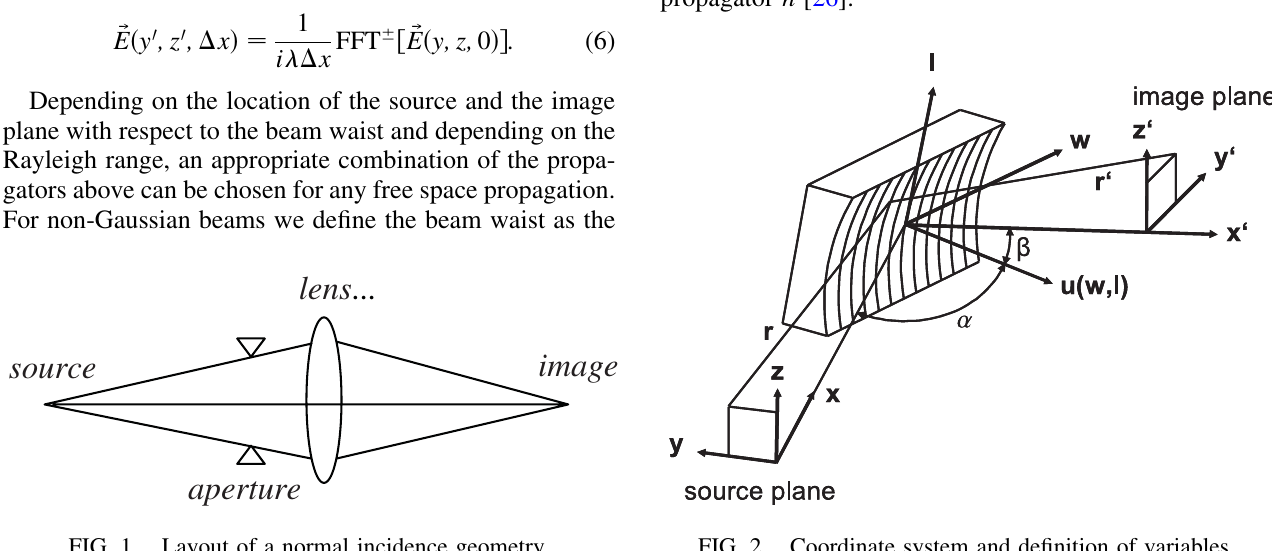
FIG. 2. Coordinate system and definition of variables. FIG. 1. Layout of a normal incidence